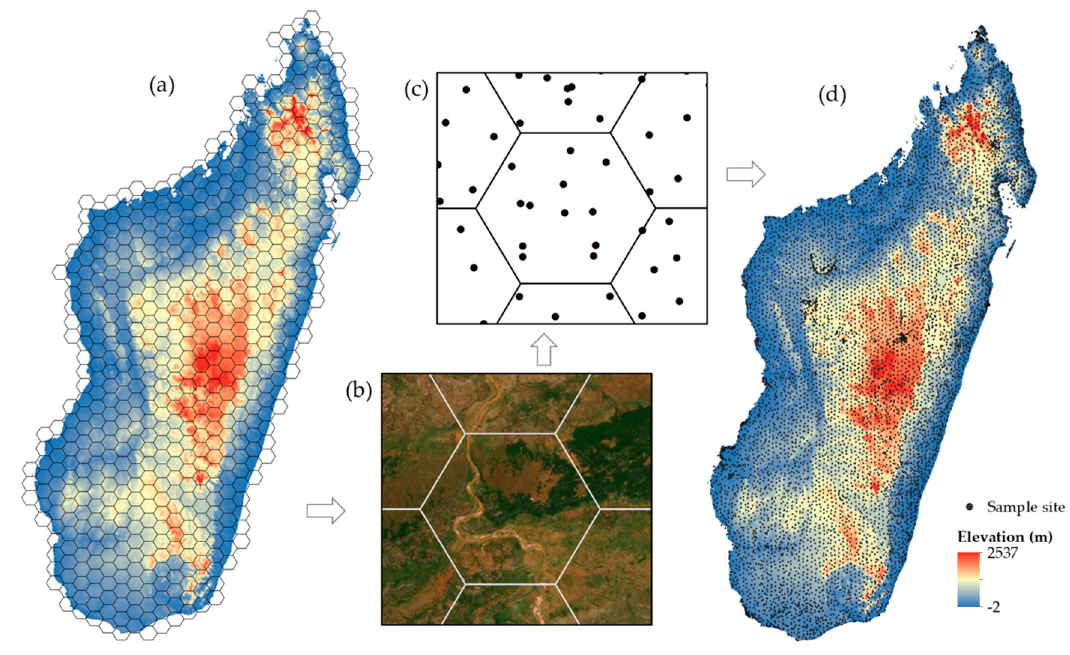
Figure 2. Schematic representation of the hexagon random sampling process in this study. Four steps: ( a ) generation of hexagons covering the whole study area; ( b ) visual interpretation of each hexagon overlaied on high-resolution Google Earth imagery; ( c ) selection of the location of land cover types; and ( d ) obtention of the sample set of the study area. Table 1. Descriptions of land cover classes included in this study.